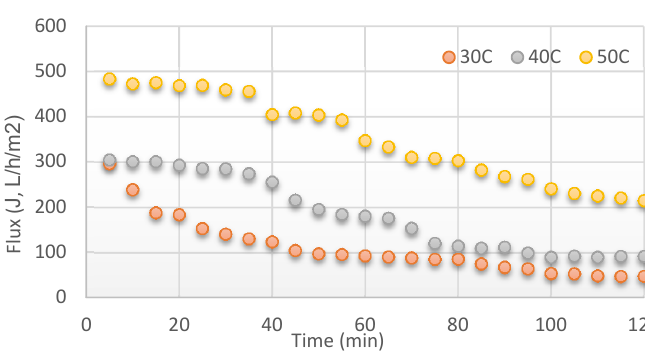
Figure 12. Effect of temperature on permeate flux of pomelo juice (TMP = 1.5 bars; membrane = 500 nm).